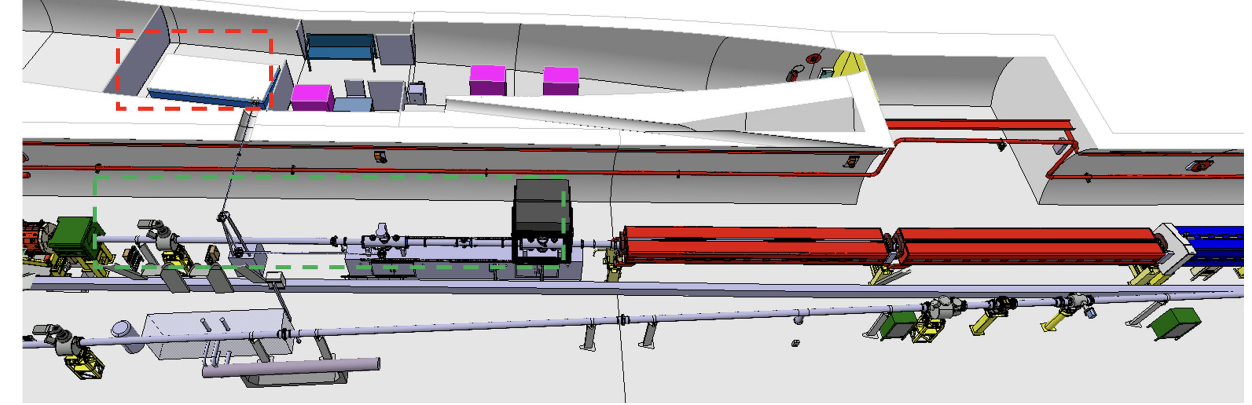
mFIG. 1. Model of the location of the Gamma Factory POP experiment in the SPS showing the TI18 tunnel on the top, the SPS ring in the middle, and the TT60 extraction line on the bottom with the partially stripped ion beam traveling from the right to the left. The model shows the foreseen location of the Fabry-Perot cavity in the SPS ring (green dashed box), the location of the optical room (red dashed box), and the laser transport line in between the